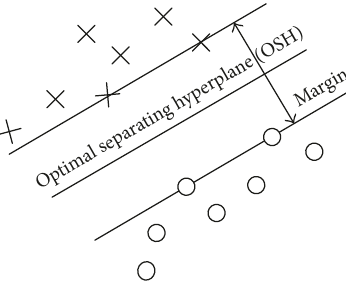
Figure 2: The OSH of a binary